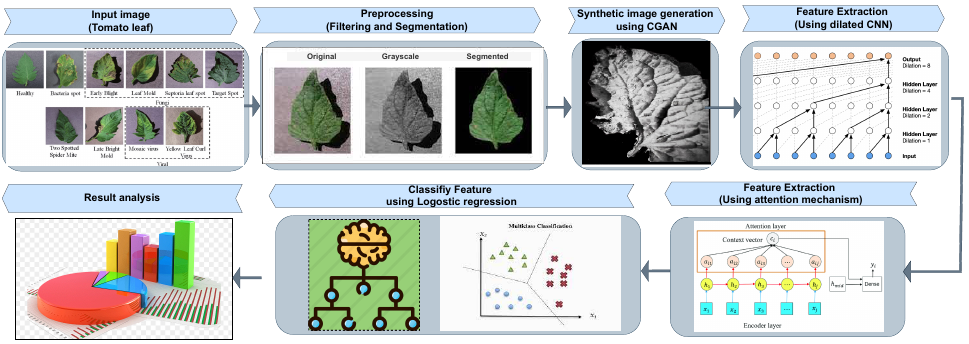
Figure 1. The overall framework of the proposed